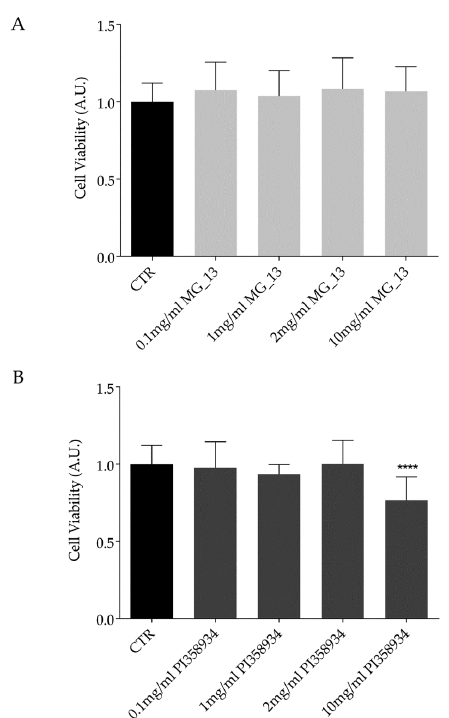
Figure 1. Cell viability of FaO cells exposed to the chickpea extracts. FaO cells were left under basal condition (CTR) or exposed to different concentrations (0.1 mg/mL, 1 mg/mL, 2 mg/mL, or 10 mg/mL) of chickpea extract MG_13. ( A ) and PI358934; ( B ) as described in the Methods Section. Cells were stained with crystal violet solution. Data are presented as means ± S.D. of 3 independent experiments and analyzed by one-way ANOVA followed by Dunnett’s multiple comparisons test. (**** p < 0.0001 vs. control diet (CTR)).